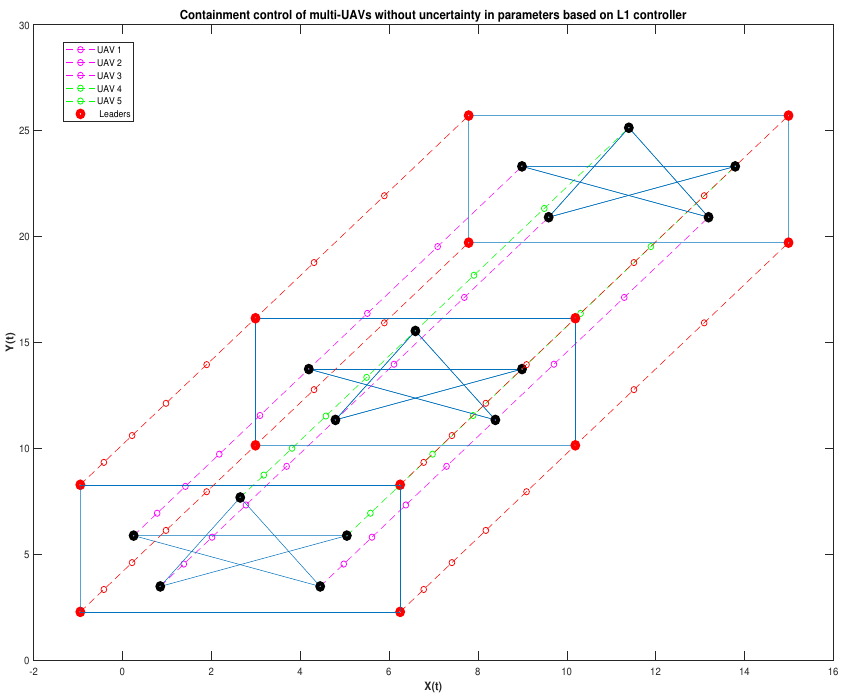
Figure 6. Full map of UAVs containment based on L 1 adaptive control without parameters